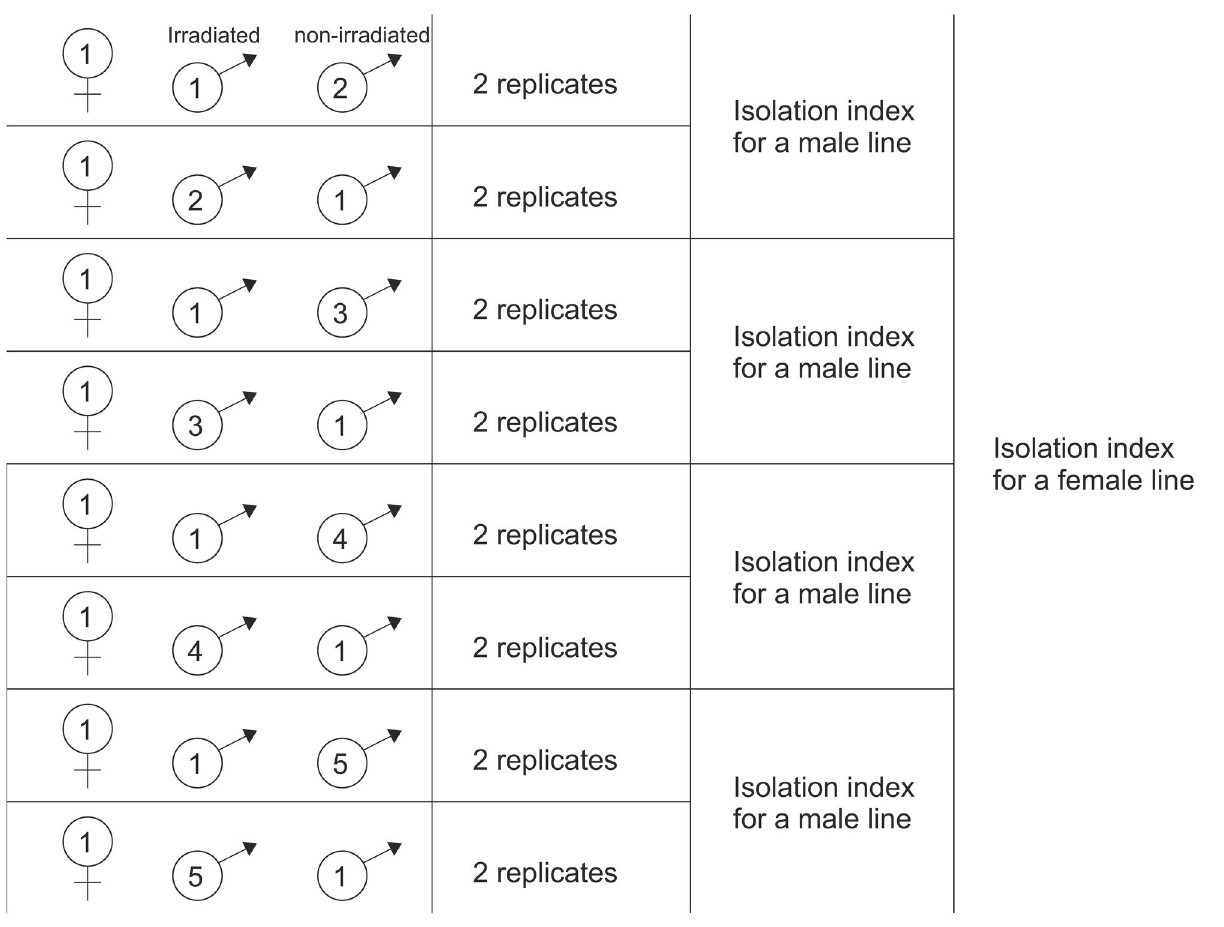
Figure 1. Schematic representation of the design of Assay I. Schematic representation of the design of Assay I and the way of calculating pre-zygotic isolation mechanisms under male competition index on the example of a female’s line 1. Procedures are described in the